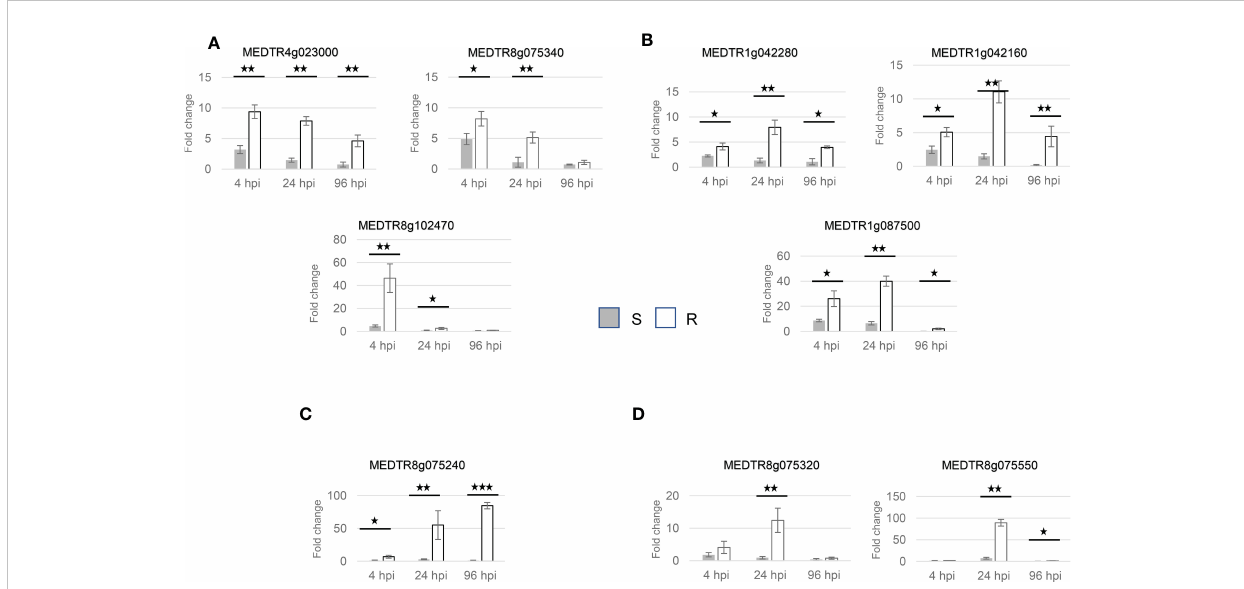
FIGURE 7 Gene expression in roots inoculated with V. alfalfae strain AFI, grouped by expression patterns. (A) Glycoside hydrolase family 1 protein (MEDTR4g023000), Osmosensor histidine kinase (MEDTR8g075340), 6-phosphogluconate dehydrogenase NAD-binding domain protein/3-hydroxyisobutyrate dehydrogenase- like 1 (MEDTR8g102470). (B) Casein kinase I-like protein (MEDTR1g042280), MATH domain protein (MEDTR1g042160), hypothetical protein MTR_1g087500 (MEDTR1g087500). (C) Rho-like GTP-binding protein (MEDTR8g075240). (D) Proteasome subunit alpha type-7-A protein (MEDTR8g075320), Pathogenesis-related thaumatin family protein (MEDTR8g075550). The fold change (expression in inoculated roots over expression in mock-inoculated roots) is calculated through DD CT by 2 -( DD CT) . The error bars represent the standard deviation of the fold-change. The fold change is calculated through DD CT by 2 -( DD CT) . The stars present signi fi cance levels derived from the T-test of mean comparison between treated susceptible and resistant pools at each time point. (*) represent p-value less than 0.05, (**) less than 0.01, (***) less than